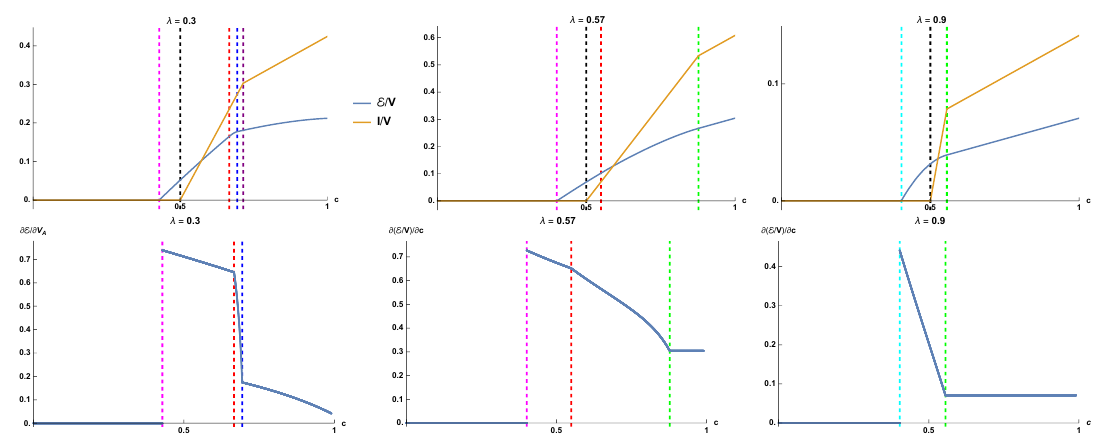
Figure 12 . Top row: the blue and orange curves respectively show E and I as a function of c along three vertical lines in the phase diagram of figure 11(b). Bottom row: ∂ E same lines. The relevant phase transitions lines from figure 11(b) are also indicated with dashed vertical